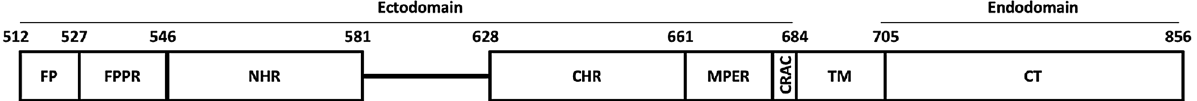
Figure 1. Schematic illustration of gp41: FP fusion peptide, FPPR fusion peptide proximal region, NHR and CHR N-terminal and C-terminal heptad repeat, respectively, MPER membrane proximal external region including the Cholesterol recognition amino acid consensus (CRAC) motif, TM transmembrane anchor, CT cytoplasmic terminus. The numbering follows the HXB2 subtype of HIV-1 (uniprot